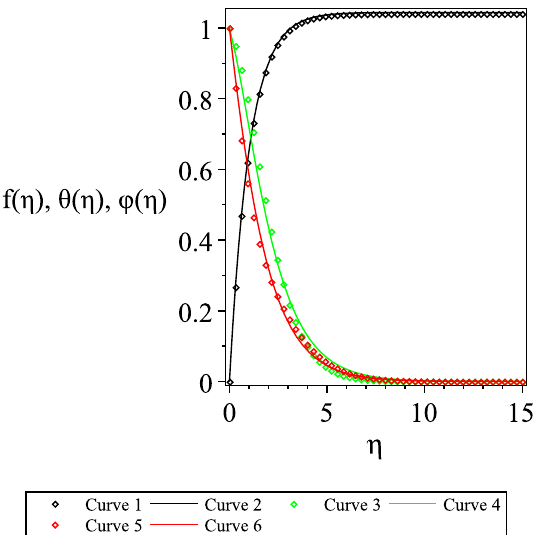
Fig. 9 Comparison of f ( η ) , θ ( η ) and φ ( η ) obtained by the MDDiM 3-term approximation and shooting method solutions with Le = 2, Nb = 2, Pr = 1, Nt = 1, n = 0 . 5, where Curve 1 is shooting method results of f ( η ) , Curve 2 is MDDiM results of f ( η ) , Curve 3 is shooting method results of θ ( η ) , Curve 4 is MDDiM results of θ ( η ) , Curve 5 is shooting method results of φ ( η ) , Curve 6 is MDDiM results of φ ( η ) .